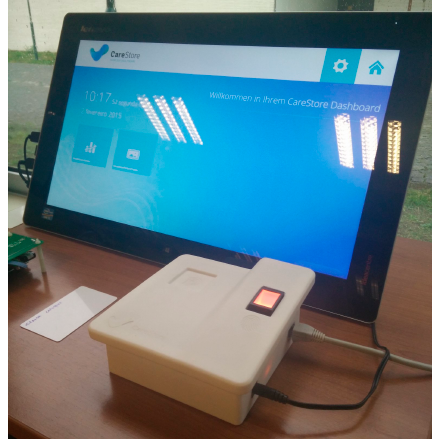
Figure 6. CAALHP and CRIP setup used for the evaluations.